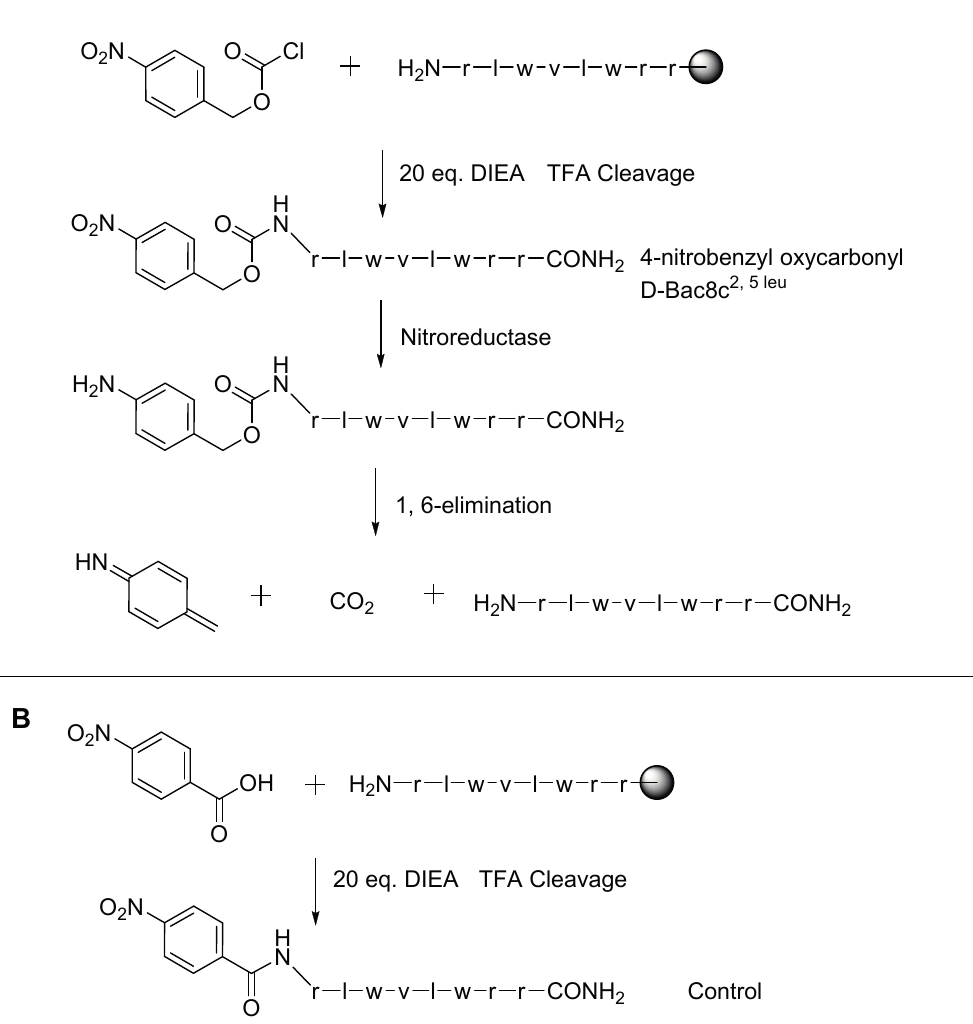
Figure 3. ( A ) Synthesis of 4-nitrobenzyl oxycarbonyl D-Bac8c 2,5 leu and release mechanism by nitroreductase of the active from the prodrug. ( B ) Synthesis of the control. Both syntheses are carried out by solid phase synthesis, the final products being isolated by cleavage from the resin with 80% trifluoroacetic acid and scavenging